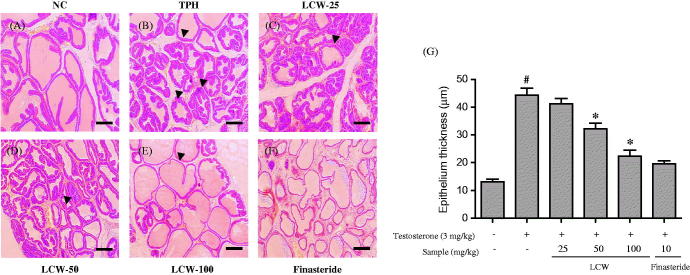
Effect of LCW on prostatic hyperplasia. (A) Normal control group, (B) TPH group, (C) LCW 25 mg/kg group, (D) LCW 50 mg/kg group, (E) LCW 100 mg/kg group, (F) finasteride 10 mg/kg group. (A–F) Prostate tissues were fixed, embedded in paraffin, and sectioned at 4 μm. Hematoxylin and eosin (H&E)-stained slides were visualized at × 100 magnification. (G) Area and length of prostatic epithelial thickness in H&E-stained slides were analyzed using Image J software (NIH, Maryland, USA), and average thicknesses were estimated by dividing areas by lengths. #p < 0.05, significantly different from the normal control group. *p < 0.05, significantly different from the TPH group.